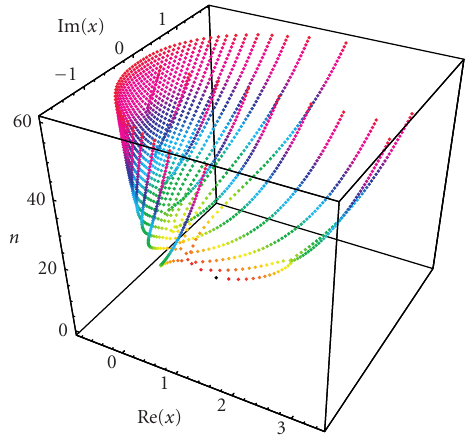
Figure 3.6. Stacks of zeros of q -Bernoulli polynomials β n ( x ,1 | 1 / 2), 1 ≤ n ≤ 60, from a 3D structure.